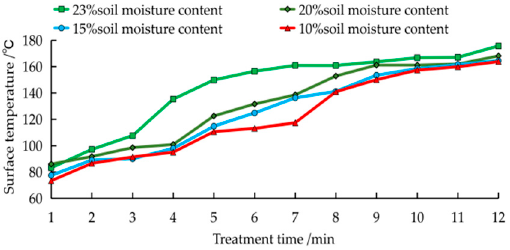
Figure 14. Surface temperature of black soil irradiated by microwaves.